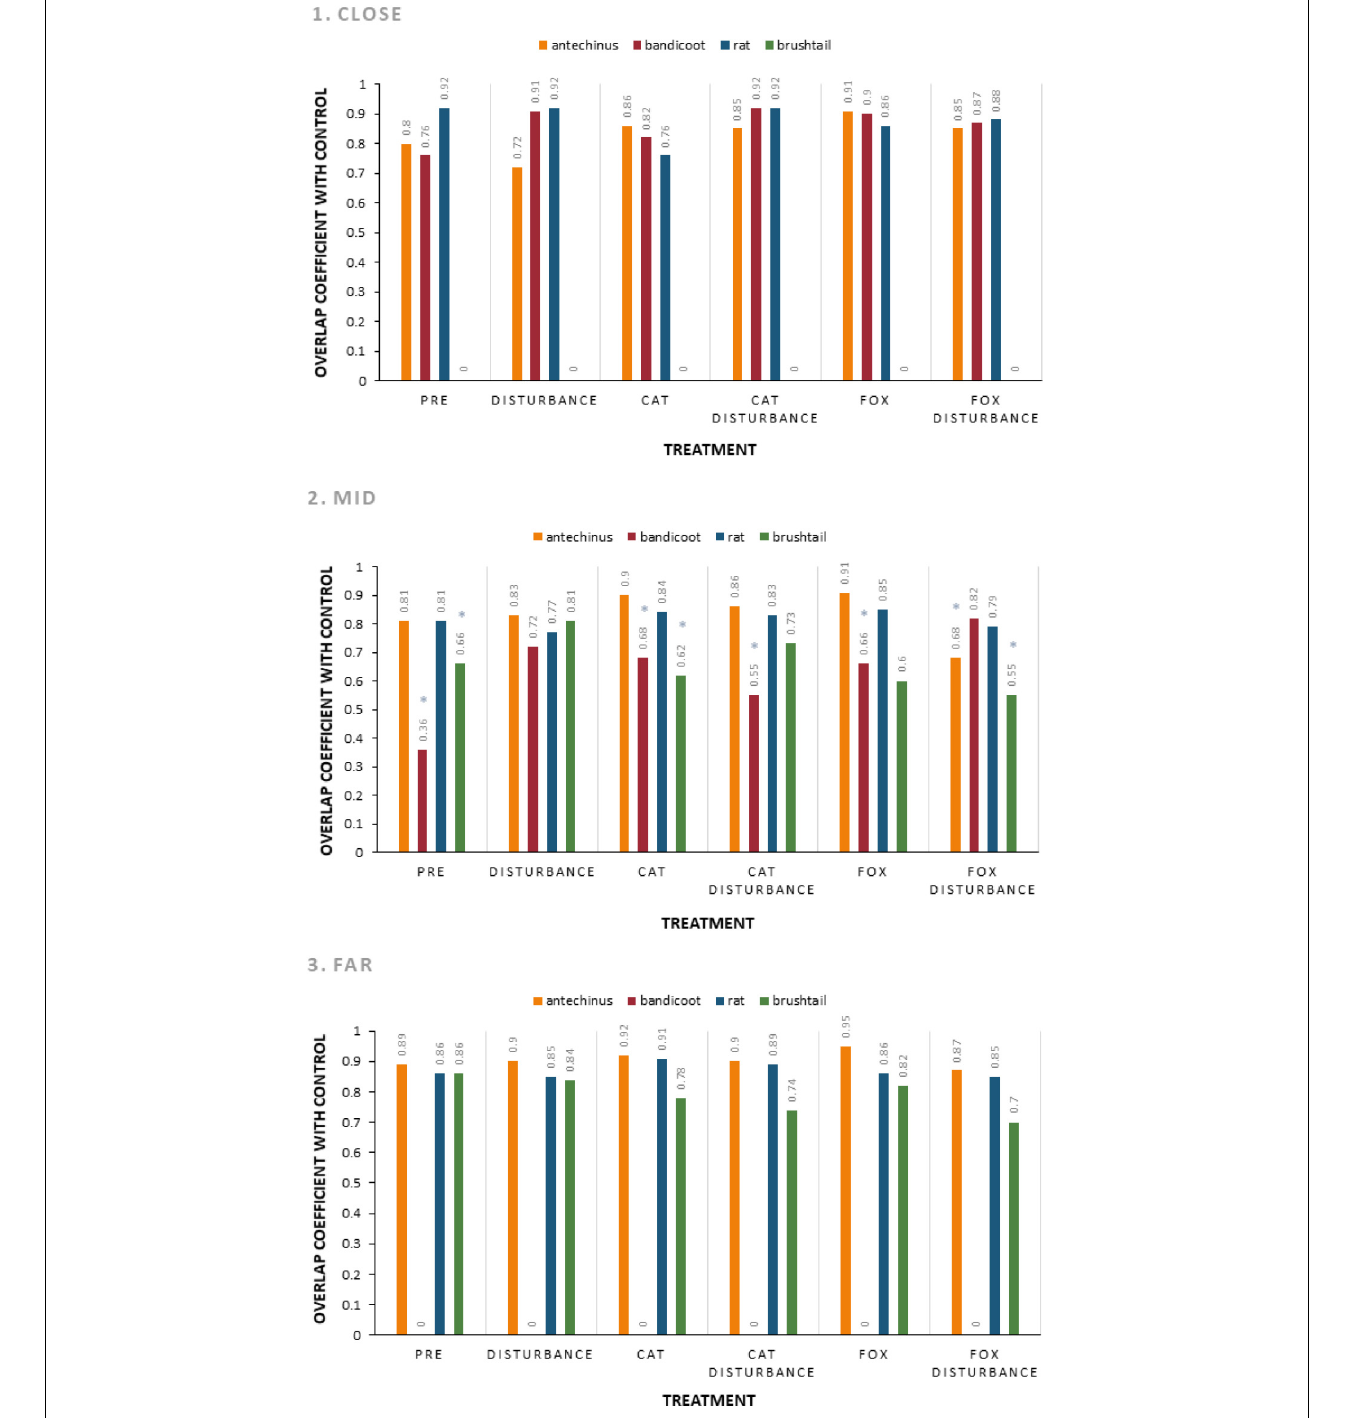
FIGURE 3 | Overlap coefficient comparing each treatment to the control, for the hours active at giving-up density stations (baited with live mealworms) for each frequently observed small mammal species (brown antechinus, northern brown bandicoot, brown and black rats combined, and common brushtail possum) along the three urban disturbance gradient environments (1. Close, 2. Mid, and 3. Far). For each species, periods active under the procedural control are compared to those under each of the six treatment conditions (pre-treatment: three nights of trials under natural conditions before the treatment trials, disturbance: human disturbance cues of continual sound and light, cat: domestic cat cues of cat integumentary scent captured on towels placed in their bedding, cat with human disturbance: the combination of these stressors, fox: red fox cues of fox integumentary scent captured on towels placed in their bedding, fox with human disturbance: the combination of these stressors). Results with “*” are considered low and are investigated further in Figure 4 .